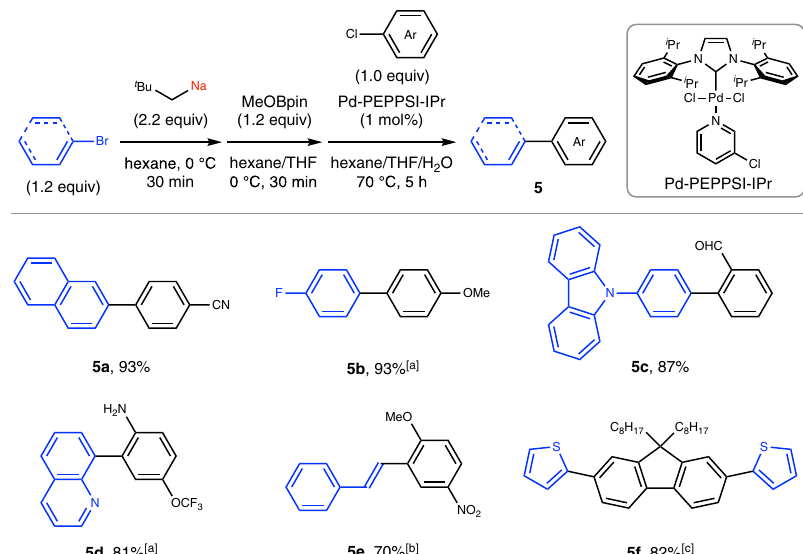
Fig. 6 Palladium-catalyzed Suzuki – Miyaura cross-coupling reactions using aryl- and alkenylsodiums. Conditions: step 1, neopentyl chloride (220 ml%) and SD (450 mol%) in hexane (2.0 mL) at 0 °C, 20 min; step 2, RBr (1.2 equiv) was added at 0 °C, 30 min; step 3, MeOBpin (1.2 equiv), and THF (0.80 mL) were added at 0 °C, 30 min; step 4, H 2 O (0.40 mL), Pd-PEPPSI-IPr (1 mol%), and ArCl (0.30 mmol, 1.0 equiv) were added and the cross-coupling reaction was performed at 70 °C for 5 h. Yields determined by isolation are shown. a Neopentyl chloride (250 mol%), SD (530 mol%), ArBr (1.4 equiv), and MeOBpin (1.4 equiv). b Pd-PEPPSI-IPr (2 mol%). c Neopentyl chloride (300 mol%), SD (630 mol%), hexane (2.5 mL), 2-bromothiophene (2.6 equiv), bromine – sodium exchange was performed for 10 min; MeOBpin (2.9 equiv), THF (1.0 mL), H 2 O (0.50 mL), 9,9-dioctyl-2,7-dibromo fl uorene (0.30 mmol, 1.0 equiv), and Pd-PEPPSI-IPr (2 mol%). SD sodium dispersion, t Bu tert -butyl, Ar aryl, MeOBpin 2-methoxy-4,4,5,5-tetramethyl-1,3,2-dioxaborolane; MeO methoxy; THF tetrahydrofuran, i Pr isopropyl.